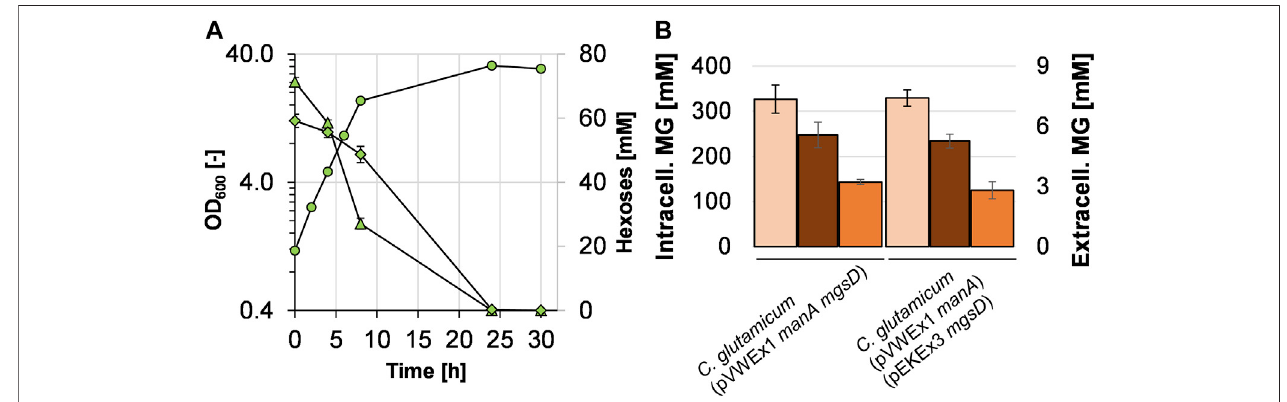
FIGURE 4 | Growth of C. glutamicum (pVWEx1 manA mgsD ) with 1% glucose (triangles) and 1% mannose (diamonds) in CGXII minimal medium (A) and comparison of intracellularly accumulated MG (light red bars), released MG (dark bars), and remaining intracellular MG (orange bars) obtained with C. glutamicum (pVWEx1 manA ) (pEKEx3 mgsD ) under the same conditions (B)